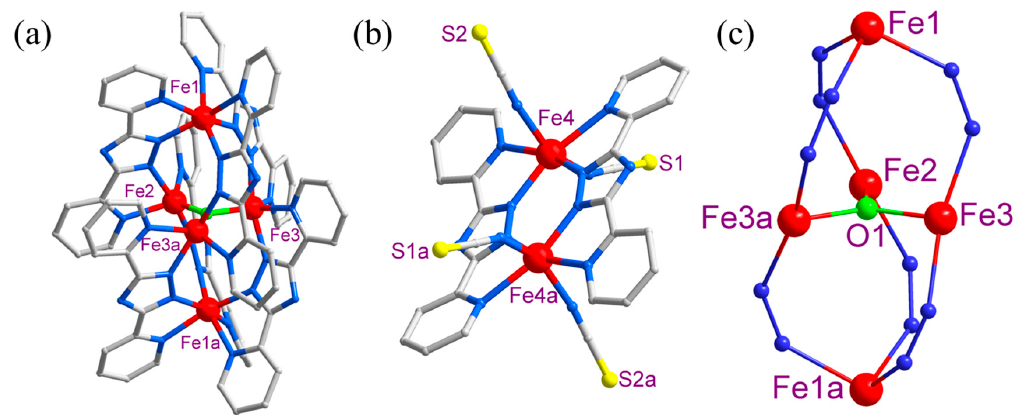
Figure 2. Structure illustrations of 2 : coordination geometries of the pentanuclear cation ( a ) and binuclear anion ( b ) and trigonal-bipyramidal core ( c ). Hydrogen atoms are omitted.